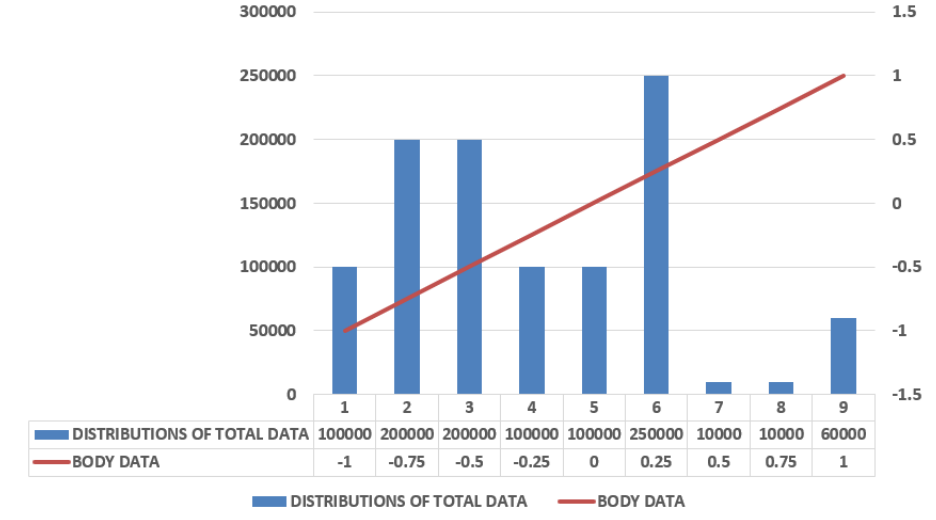
Figure 9. Depiction of Gaussian data with respect to data of